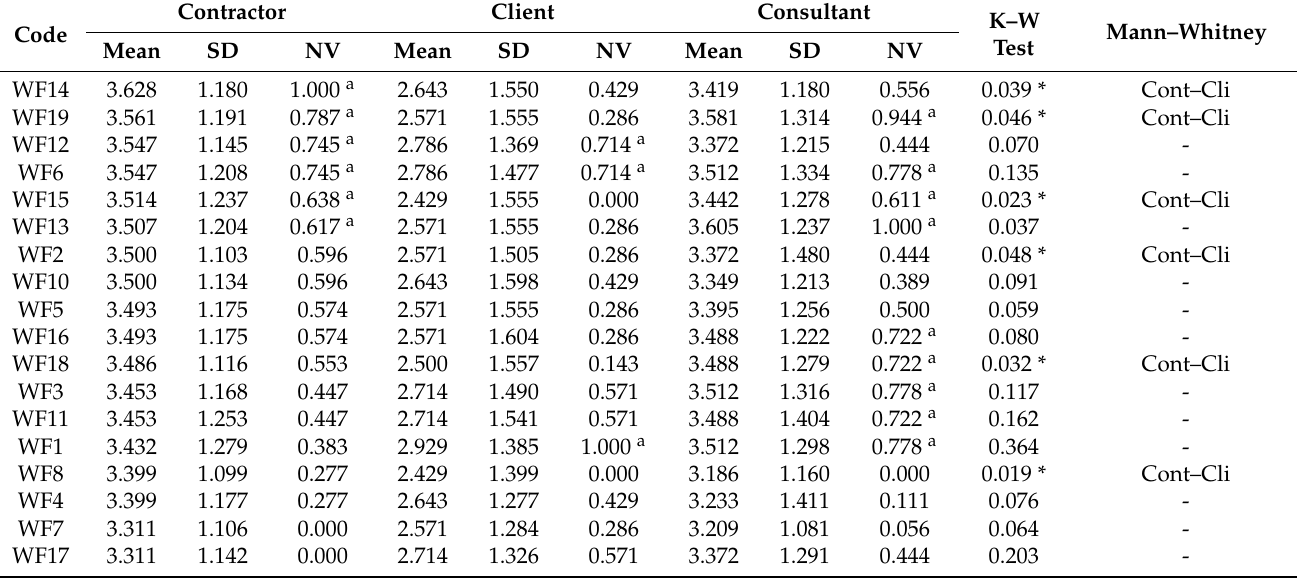
Table 5. Results of mean ranking analysis and Kruskal–Wallis test according to organization